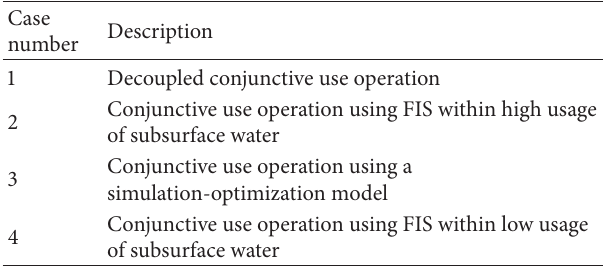
Table 3: Case abstract in the